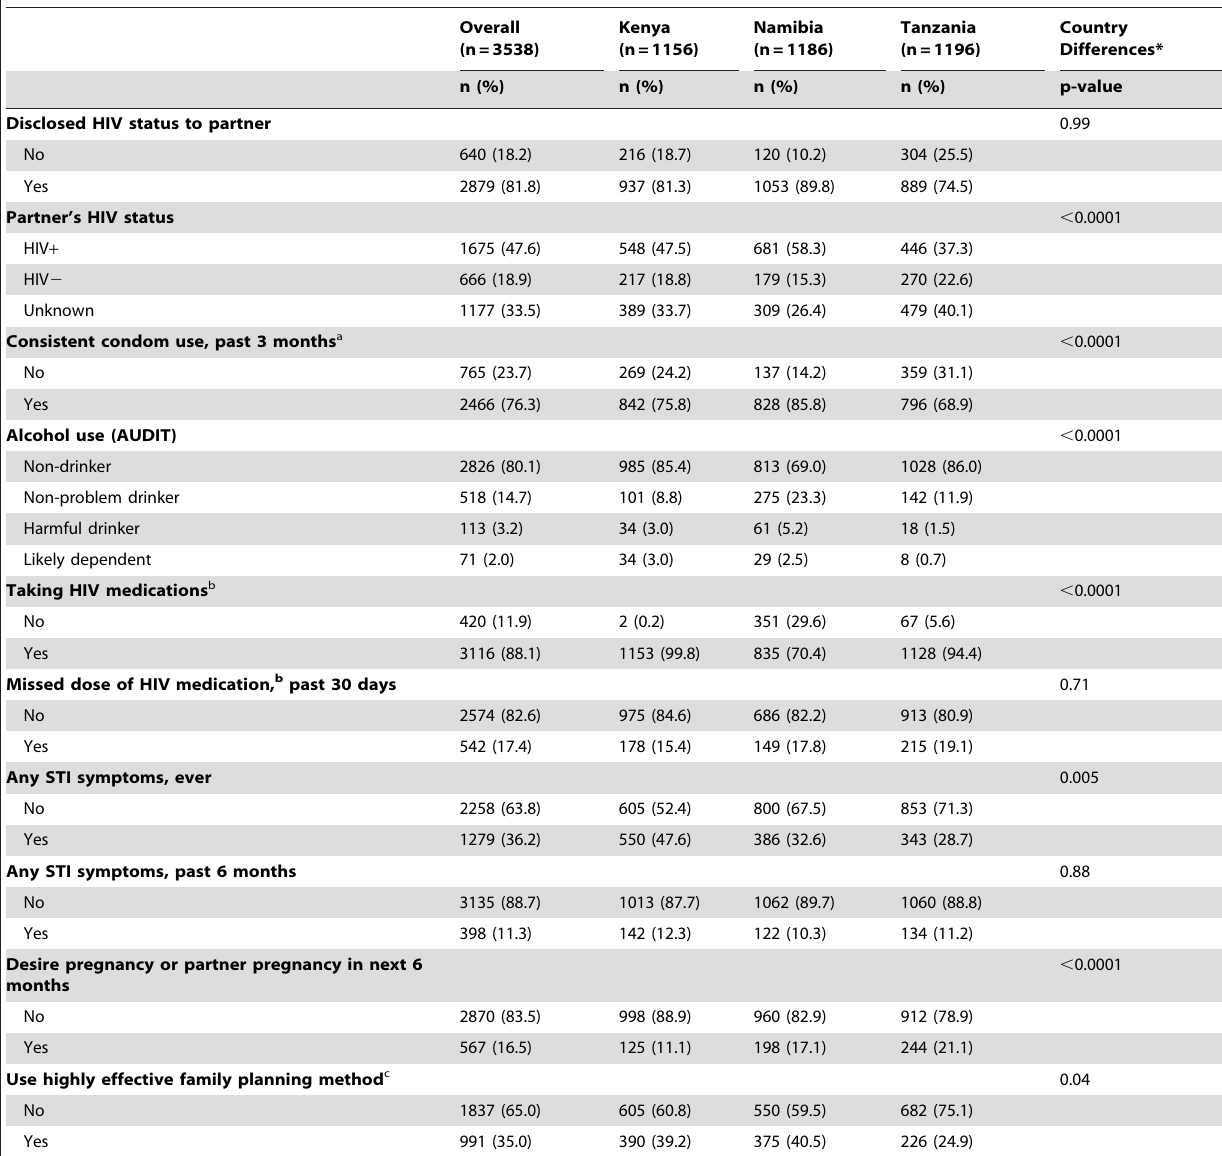
Table 2. Participant baseline HIV risk behaviors by